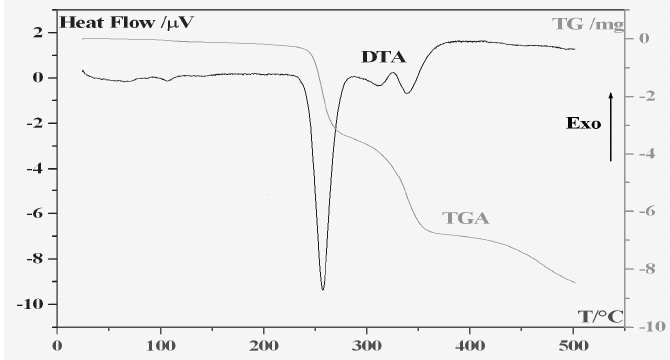
Figure 5. DTA and TGA curves of [C